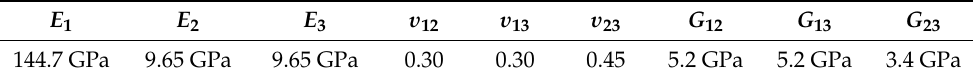
Figure 2. FE model of the CFRP metamaterial. Table 1. The material properties of the CFRP origami